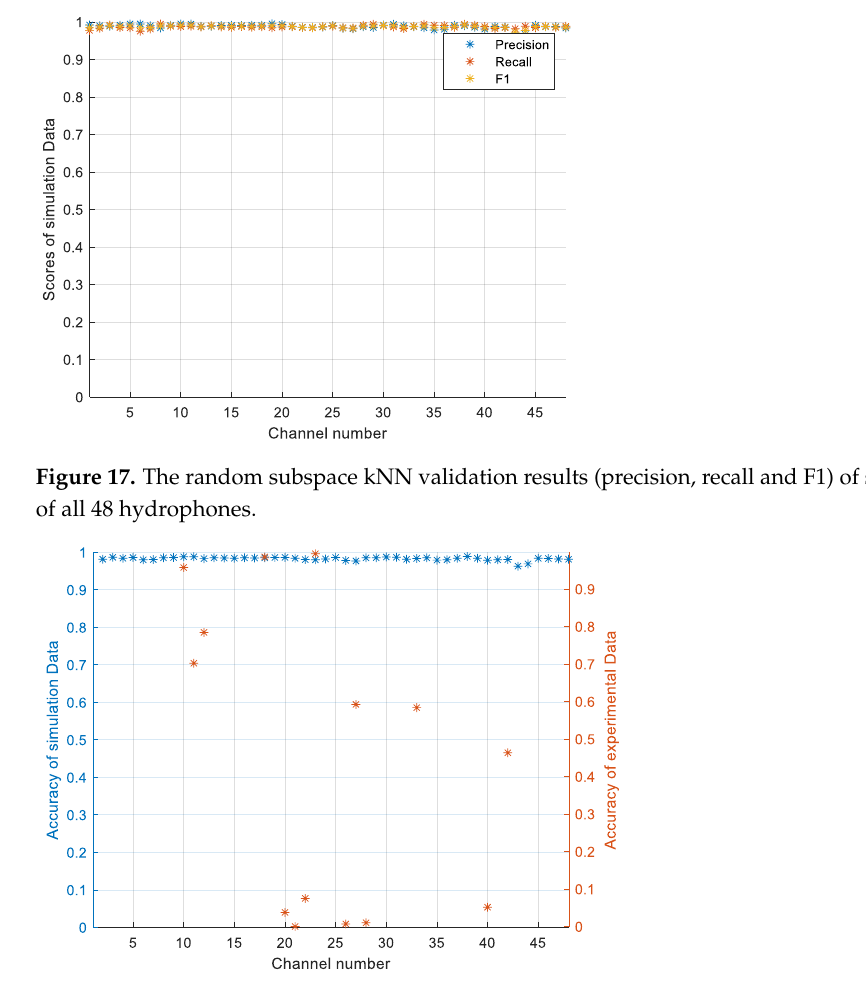
Figure 18. The random subspace kNN validation accuracy of simulation data and testing accuracy of experimental data of all 48 hydrophones.